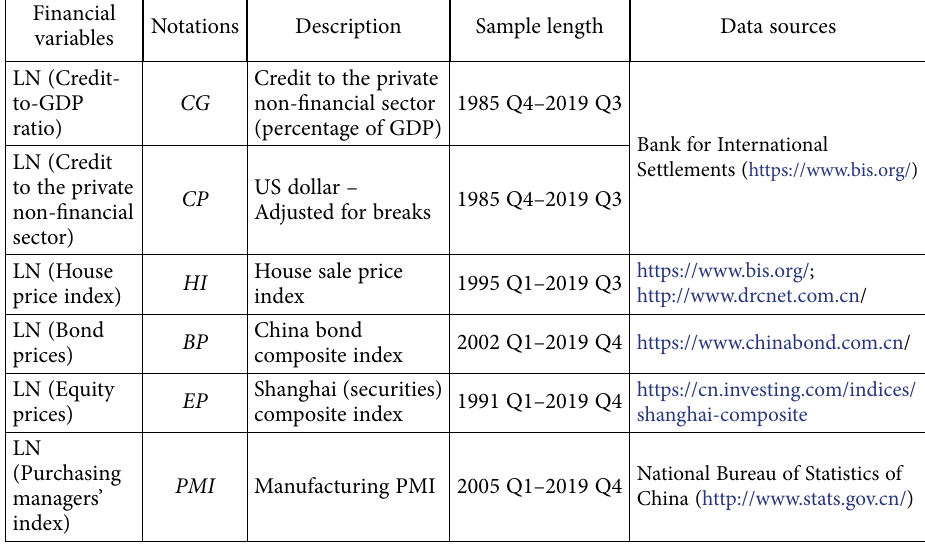
Table 1. Definition and sources of financial variables (source: authors’ own model from the listed databases) Financial